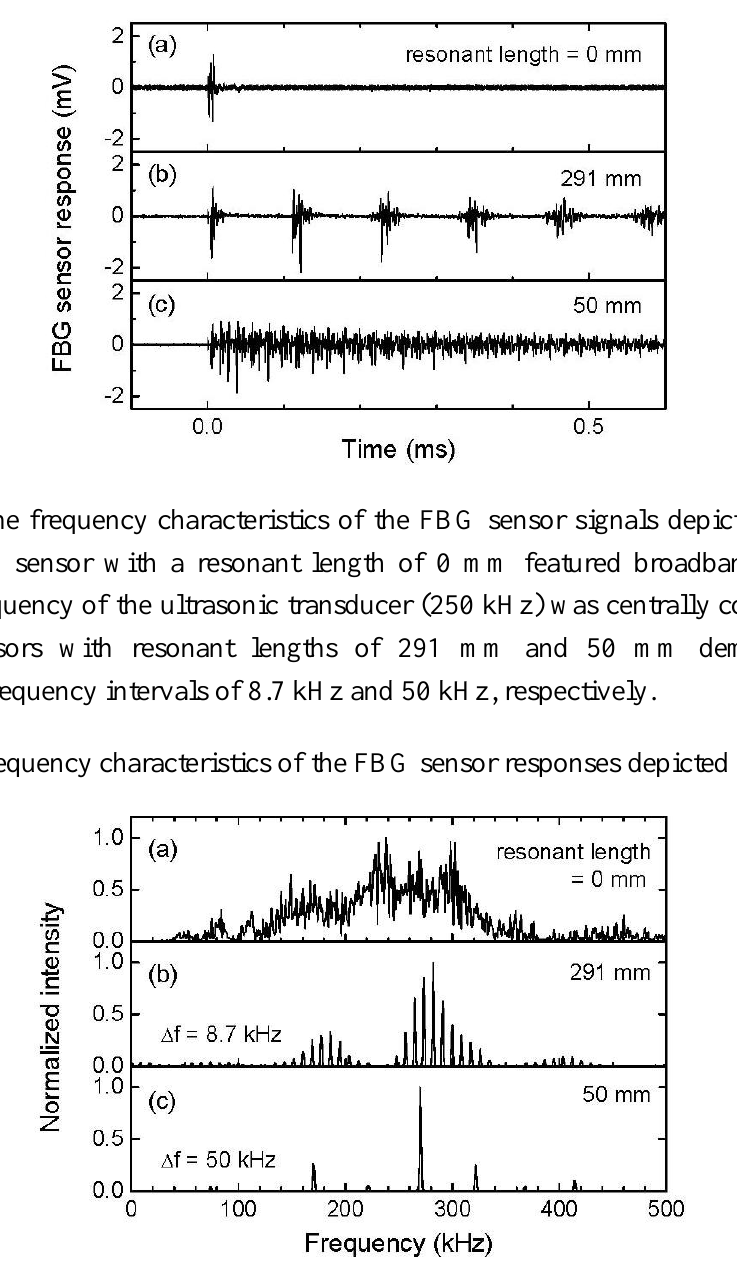
Figure 4. The 512-time-averaged ultrasonic responses of FBG sensors with resonant lengths of ( a ) 0 mm, ( b ) 291 mm, and ( c ) 50 mm.